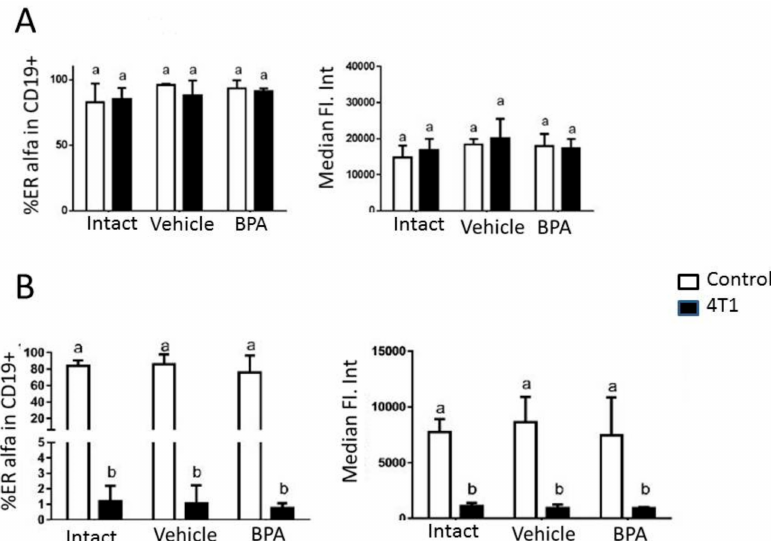
Figure 4. ( A ): Evaluation of ER α expression in terms of percentage of ER α + cells and level of expression represented by the median intensity of fluorescence in draining peripheral lymph nodes using flow cytometry. No changes are observed between experimental groups. ( B ): Evaluation of ER α expression in terms of percentage of ER α + cells and level of expression represented by the median intensity of fluorescence in spleen. It was observed that the B lymphocytes of the animals that developed tumors had a lower expression of ER α compared to healthy individuals. This phenomenon was more evident in the groups treated with vehicle and BPA. Data were obtained from 2 independent experiments and are expressed as mean ± SD; n = 10 per group. Notation: (b (cid:44) a), p <